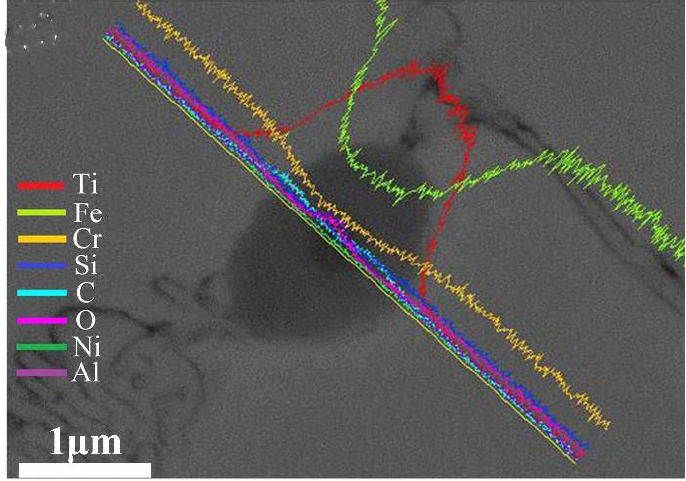
Figure 9. Energy dispersive spectroscopy (EDS) linear elemental distributions of eyeball-like phases in Figure 8a.